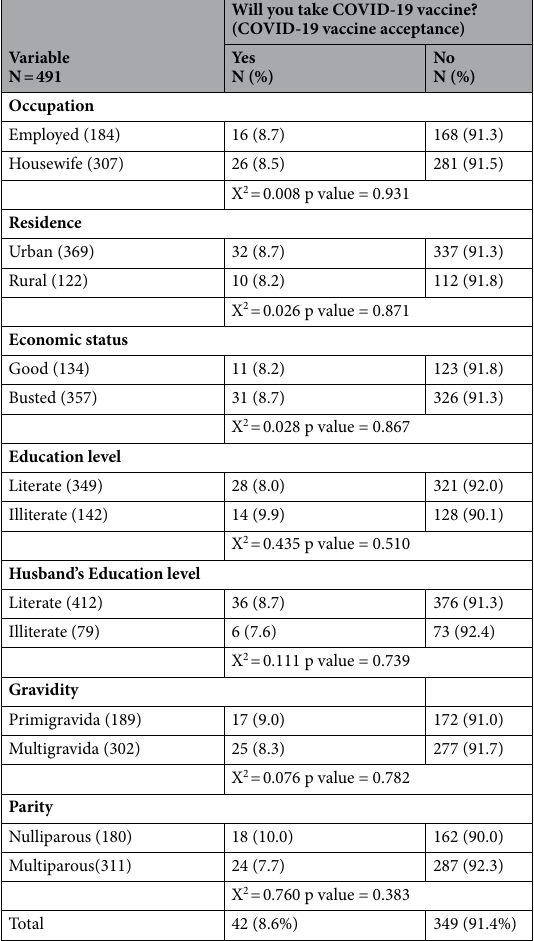
Table 2. Association between selected socio-demographic variables and COVID-19 vaccine